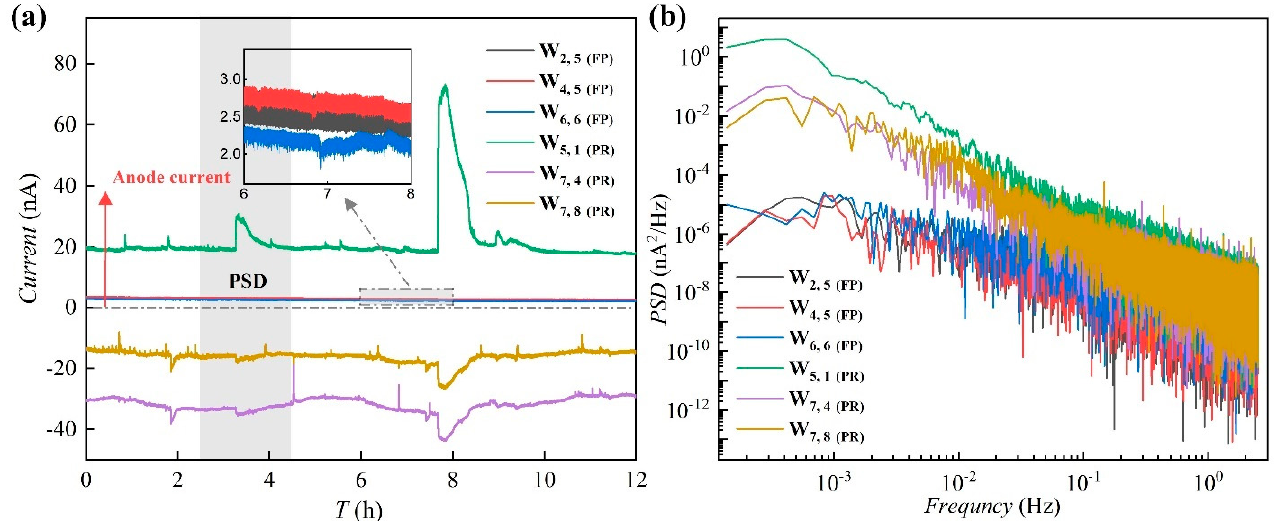
Figure 9. ( a ) Time dependence of the galvanic currents among the selected milli-electrodes and the other milli-electrodes in WBE; ( b ) PSD spectrum of selected galvanic currents curves.